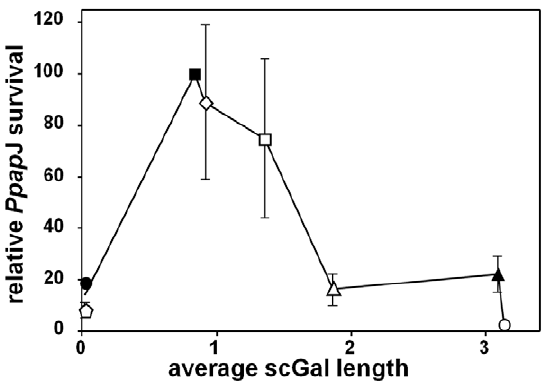
Figure 3. Relationship between L.major scGal-LPG PAMPs and Ppap J midgut survival post-blood meal expulsion. Relative survival of L. major promastigotes in infected Ppap J sand flies which have expelled their digested blood meal is plotted as a function of the average LPG scGal length, using data in Table 1. The average ( 6 SEM) of two or more independent experiments is shown for FV1 ( & ), LV39c5 ( m ), SD- SSU:SCG5 (open pentagon), SD-c SCG3 ( e ), SD- SSU:SCG3 ( % ), SD- SSU:SCG1 ( n ), and SD- SSU:SCG4 ( # ). We include data here for SD ( from a single experiment, which is consistent with previous studies [21,23].